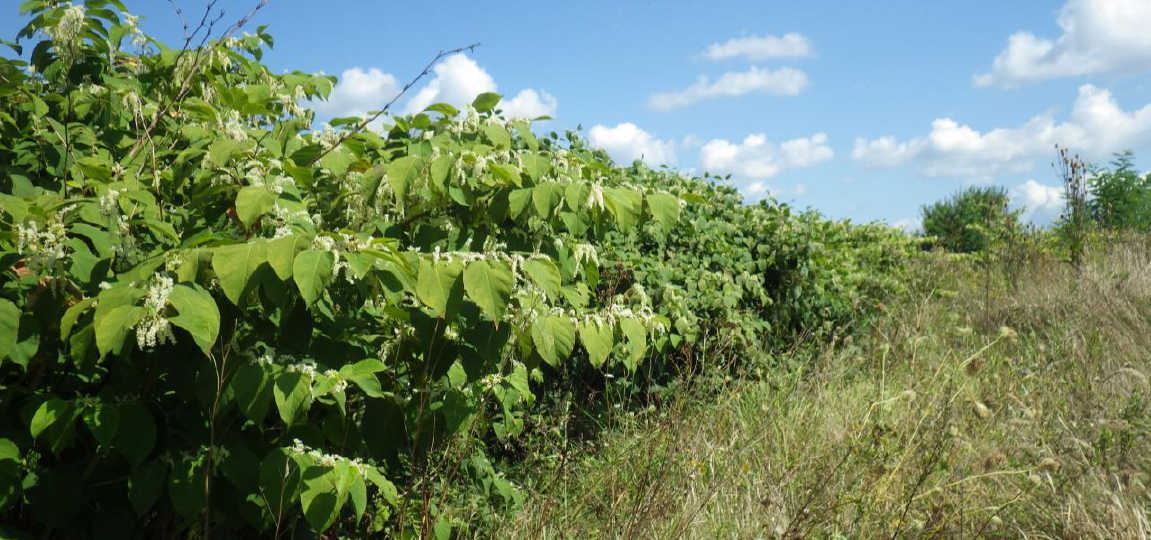
Fig. 7. Reynoutria japonica Houtt. in